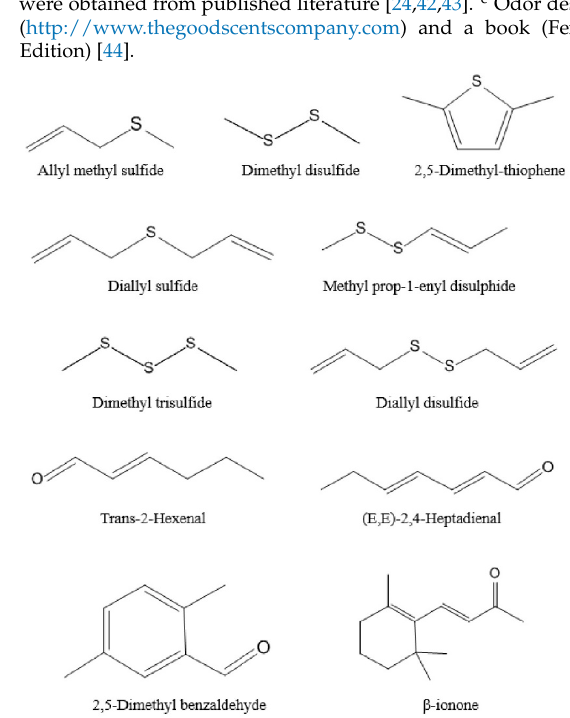
Figure 4 . The radar fingerprint chart of aroma composition of Chinese chive.